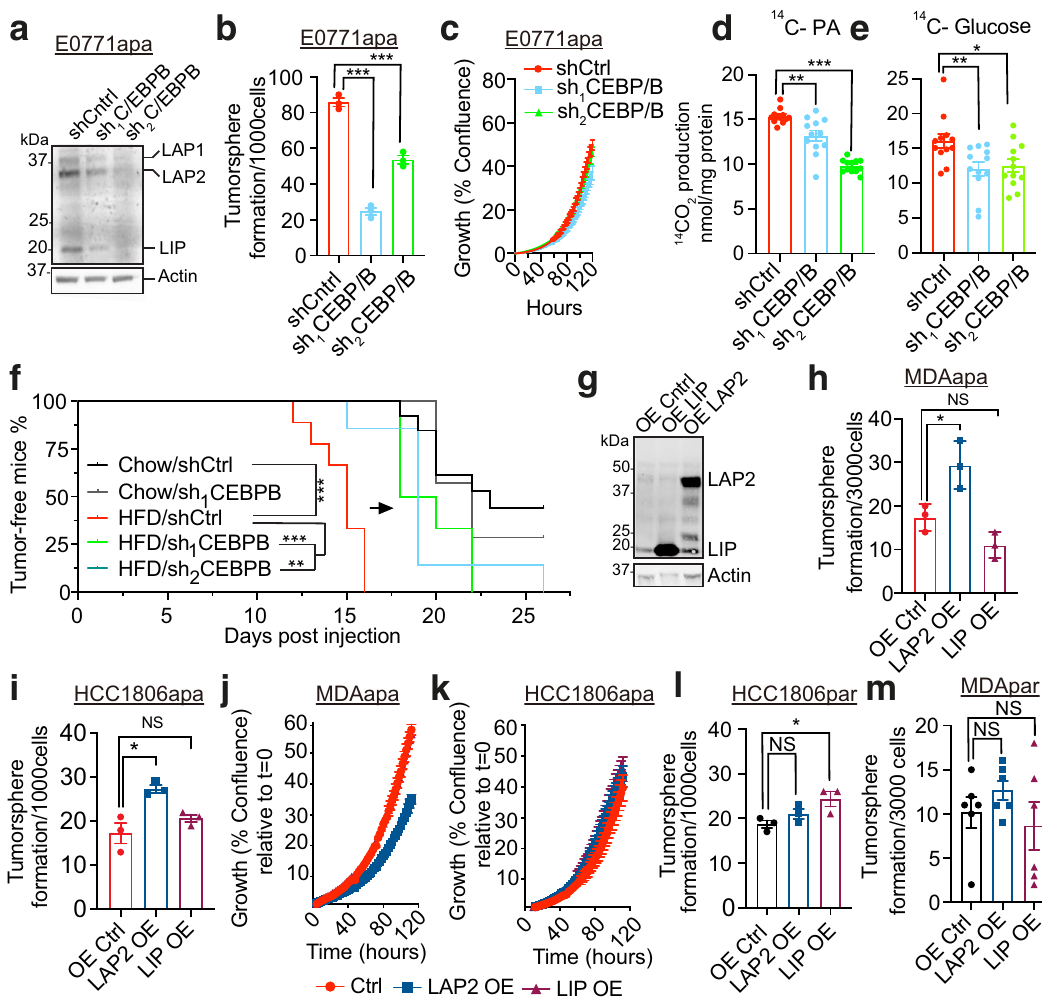
Fig. 4 C/EBPB promotes tumor stemness speci fi cally in obese environments. a Western blots of C/EBPB and Actin in cell lysates extracted from knockdown control (shCtrl) and two independent C/ebpb knockdown adapted E0771 cells. Three C/EBPB isoforms, LAP1, LAP2, and LIP are marked in the blots. Experiment was independently repeated twice. b The changes of tumorsphere formation upon knockdown of C/ebpb on adapted E0771 cells. Data are represented as mean ± SEM of 3 replicates. P ctrl/sh1 < 0.0001, P ctrl/sh2 = 0.0006. c Proliferation assay of control and C/ebpb knockdown